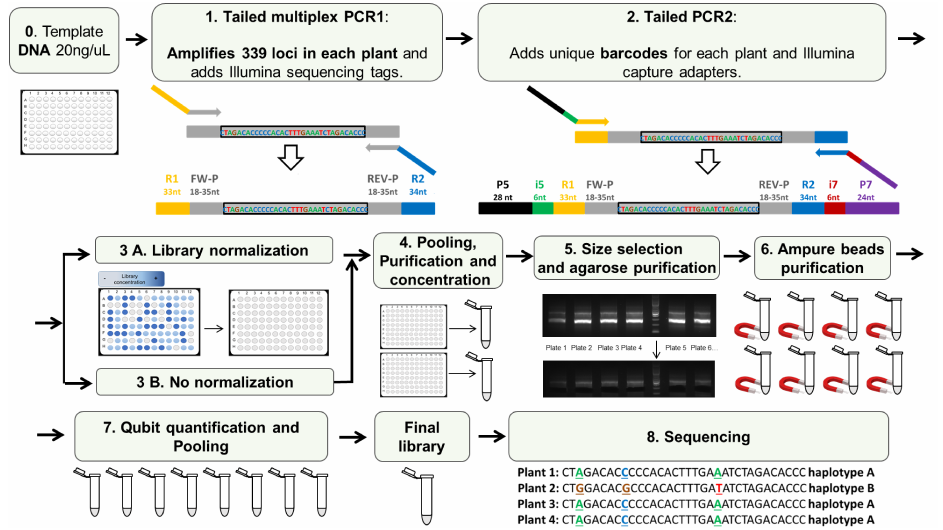
Figure 3. PotatoMASH library